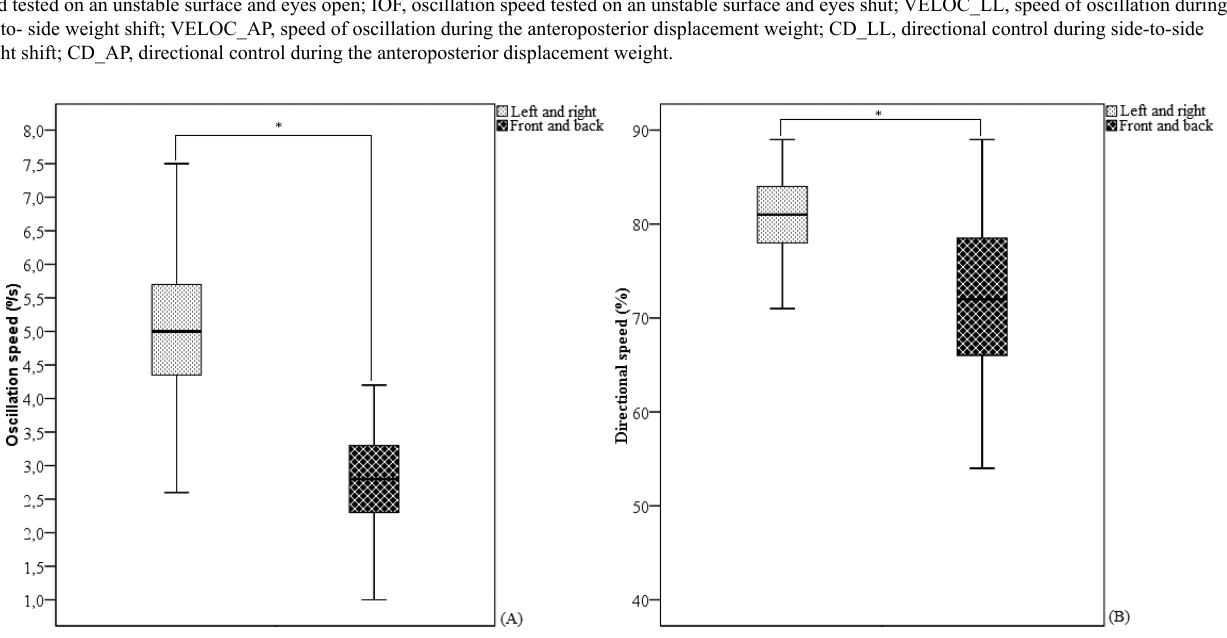
Figure 3 – Analysis if the dynamic postural balance. (A) Comparison of the oscillatory speed during the left/right movements and forward/back- ward movements. (B) Comparison of directional control during the left/right movements and forward/backward